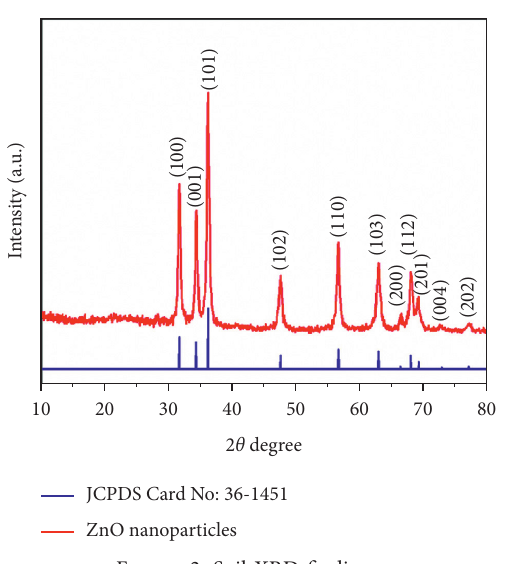
Figure 2: Soil XRD